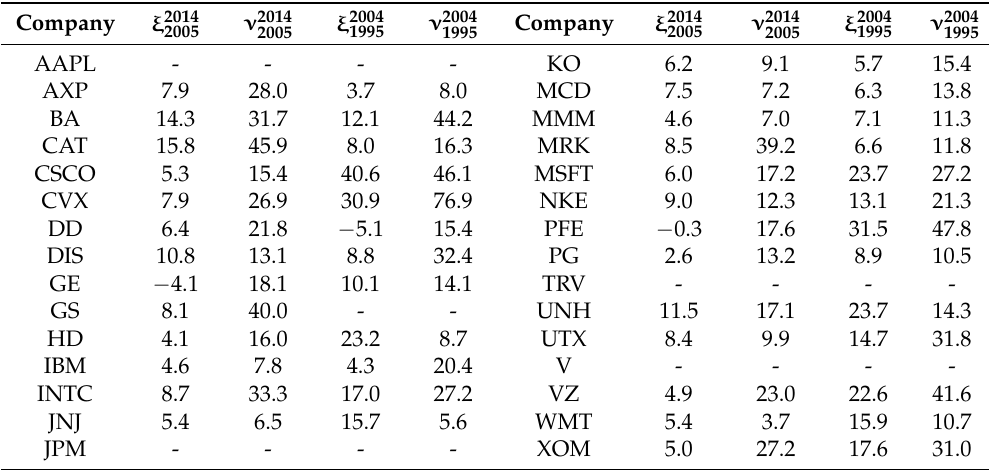
Table A1. Estimated parameters ξ ( % ) and ν ( % ) , for each company of INDU index. Company